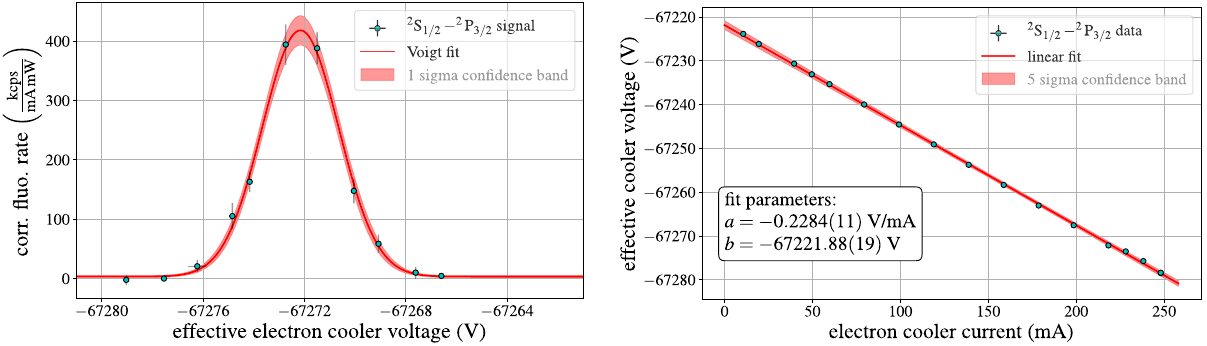
2 S 2 P 1 / 2 − 3 / 2 transition at a cooler current of 218 mA. Right: